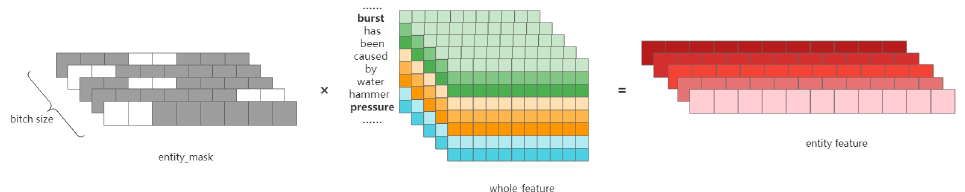
Figure 2. This is how the mask extractor works. The black and white vectors on the left side of the figure represent the entity mask, which is used to mask words outside the entity, where the white squares represent unmasked and the black squares represent masked. The entity perform a matrix multiplication operation to extract the features of the entity